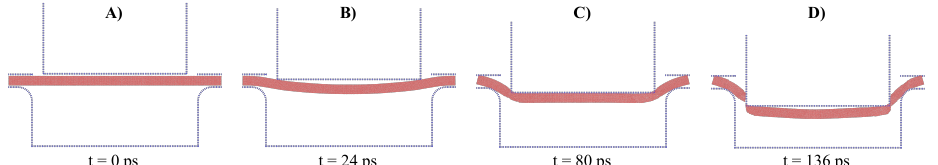
Figure 3. The snapshots of the forming process at low-speed (1 Å/ps) with the cylindrical punch. ( A ) At the start of the forming process when t = 0 ps, ( B ) deformation in progress at t = 24 ps, ( C ) start of the blanking process t = 80 ps, and ( D ) a blanked piece from workpiece falls into the die at t = 136 ps.